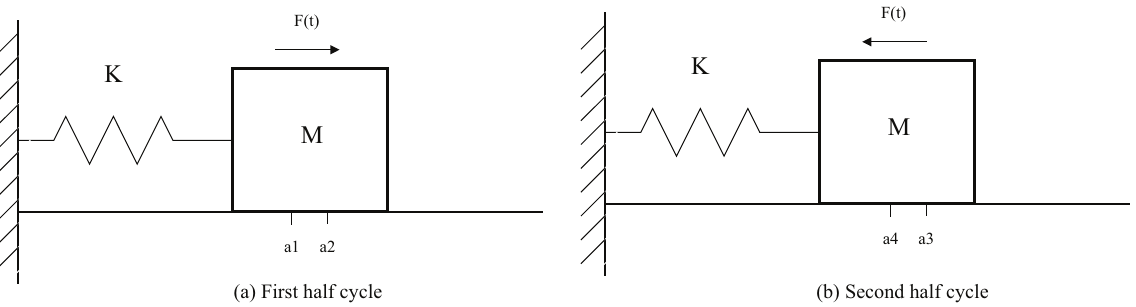
Fig. 2. Schematic diagram of the vibro-impact